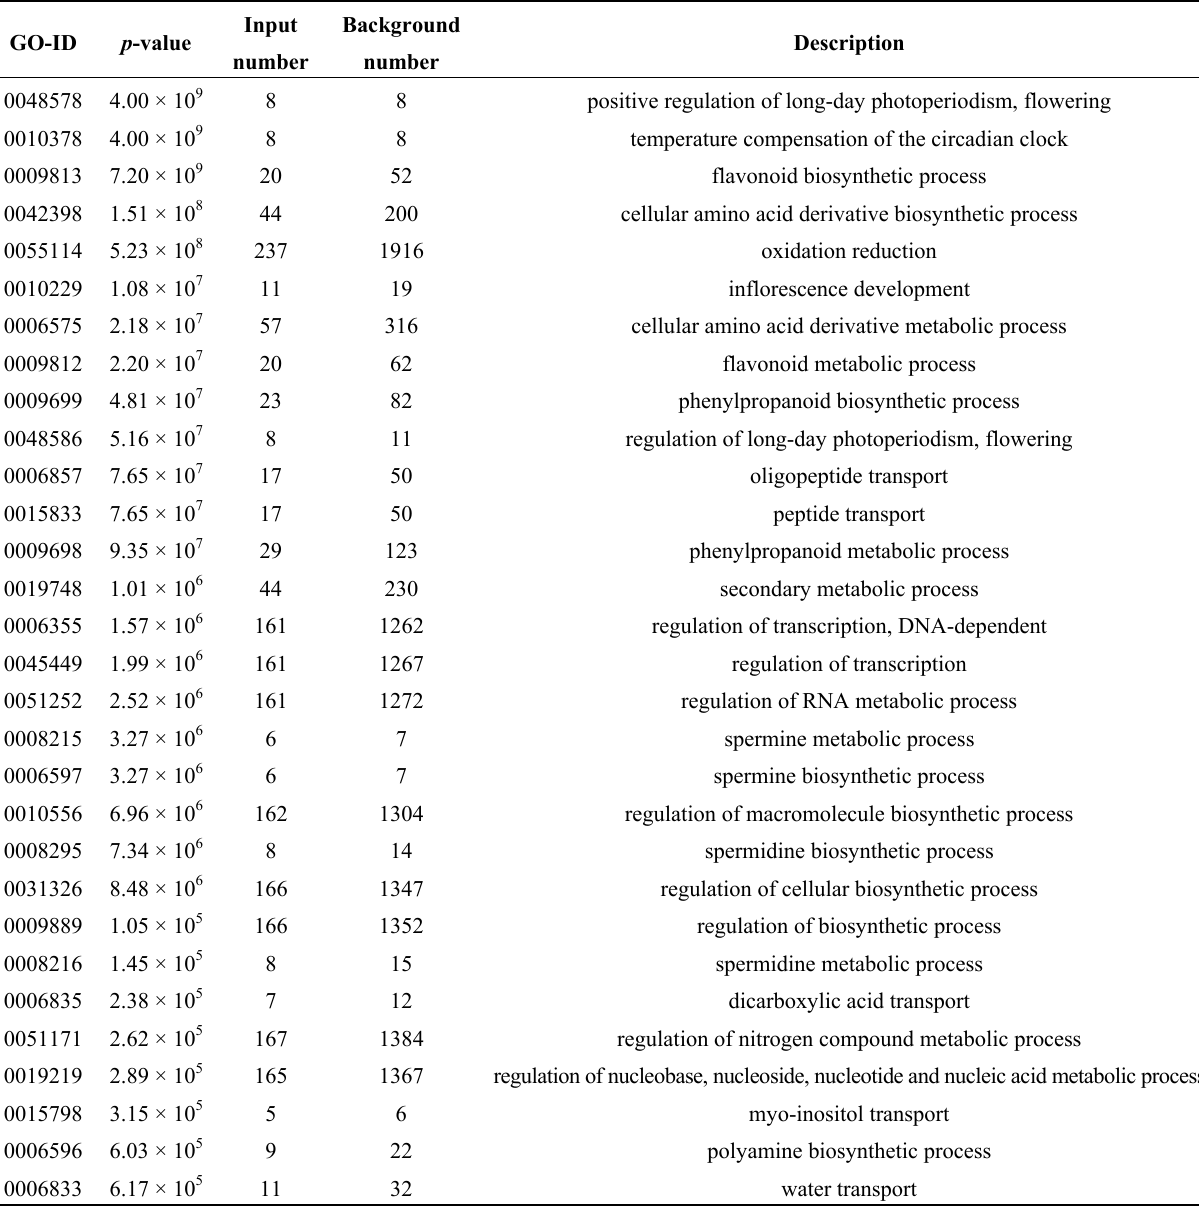
Table 4. Over-represented GO terms of CF-specific